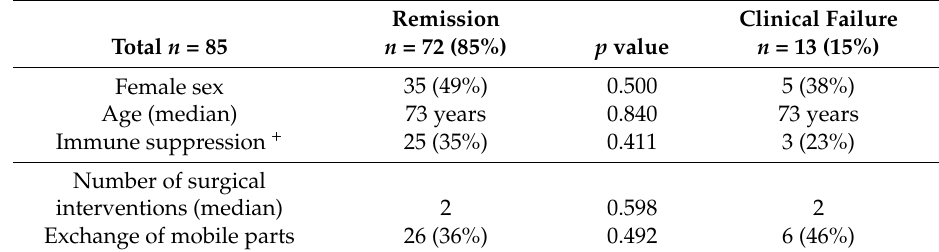
Table 2. Comparisons for the subset of 85 episodes with at least two years of active follow-up.